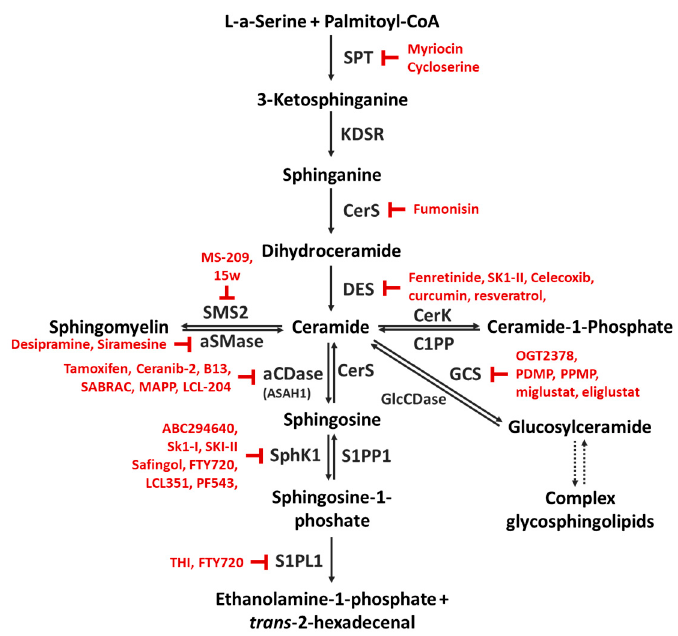
Figure 3. Some chemical inhibitors used to target sphingolipid metabolism. Abbreviations: aCDase, acid ceramidase; CerK, ceramide kinase; CerS, (dihydro)ceramide synthase; C1PP, ceramide-1-phosphate phosphatase; DES, dihydroceramide desaturase; GCS, glucosylceramide synthase; GlcCDase, glucosylceramidase; KDSR, 3-ketosphinganine reductase; PDMP, 1-phenyl-2-decanoylamino-3-morpholino-1-propanol; PPMP, 1-phenyl-2-palmitoylamino-3-morpholino-1- propanol; aSMase, acid sphingomyelinase; SMS2, sphingomyelin synthase 2; SphK1, sphingosine kinase 1; S1PL1, sphingosine-1-phosphate lyase; S1PP1, sphingosine 1-phosphate phosphatase; SPT, L-serine palmitoyltransferase.